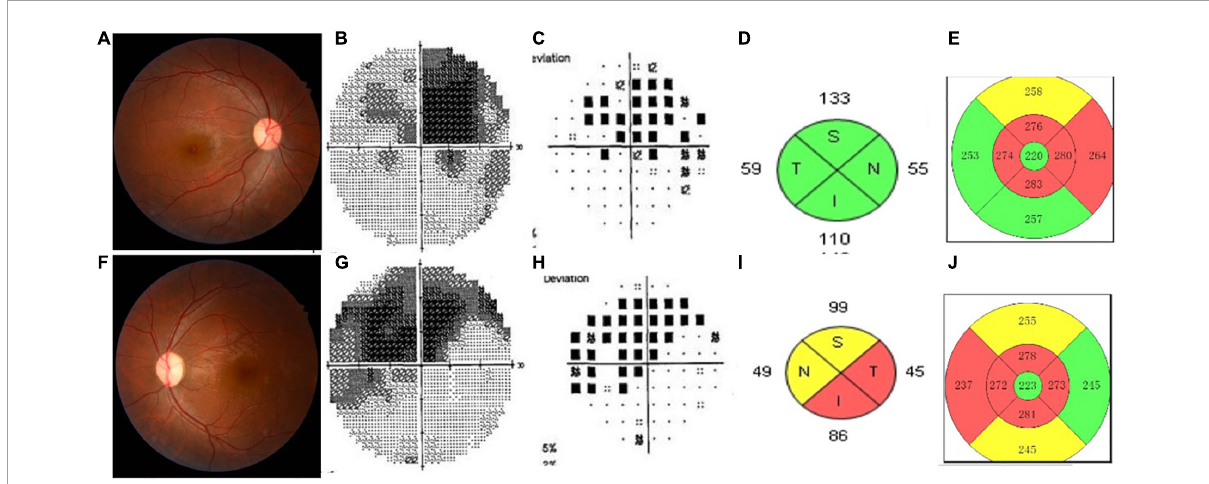
TABLE 3 The characteristics of MRI, treatment, and cerebrospinal fluid (CSF) with Leber’s hereditary optic neuropathy (LHON) plus patients. Case MRI Methylprednisolone, Prevention CSF mg, initial Intravenous Oral WBC Total protein (10 6 /L) (mg/L)